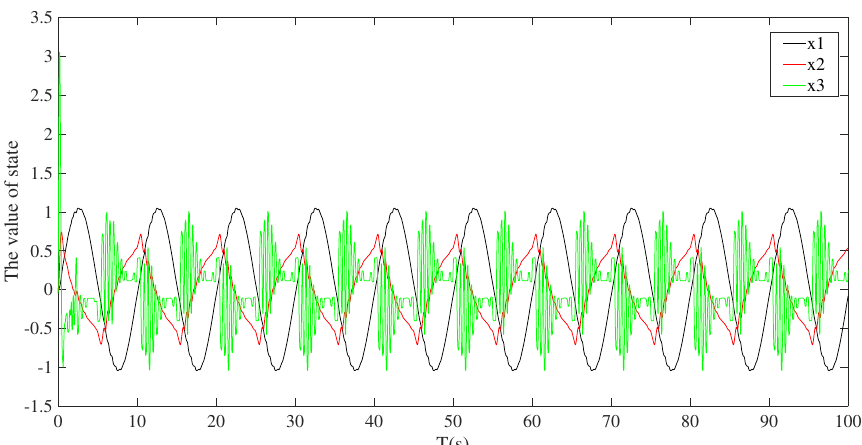
Figure 4. State curves in known time-varying delay form (with dead-zone compensation controller).